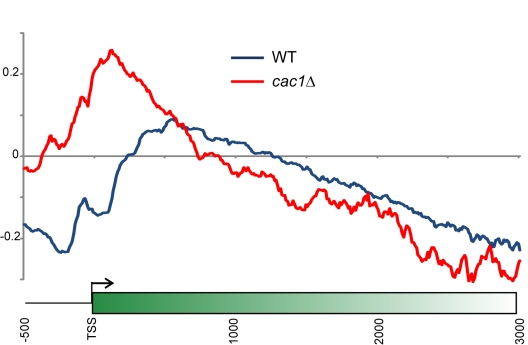
Effects of Chromatin Assembly Factor-1 complex on ancestral H3
patterns.Yeast lacking CAF-1 subunit Cac1 were processed as in Figure 1A, and HA/T7
ratio averages are shown for all genes in wild-type and
cac1Δ mutants 3 generations after release.